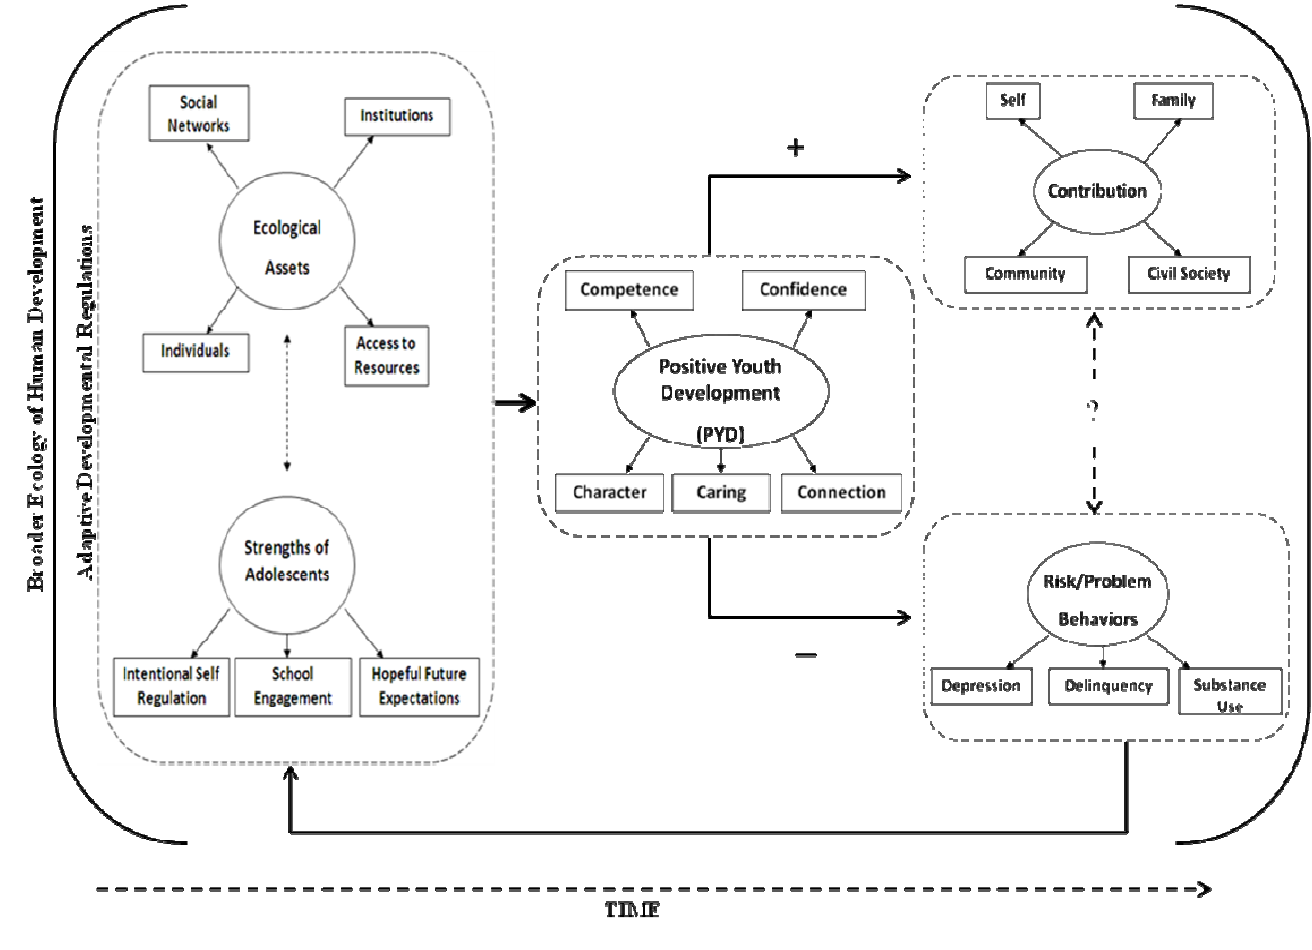
A relational developmental systems model of the individual (cid:1) (cid:2) context relations involved in the Lerner and Lerner conception of the PYD developmental